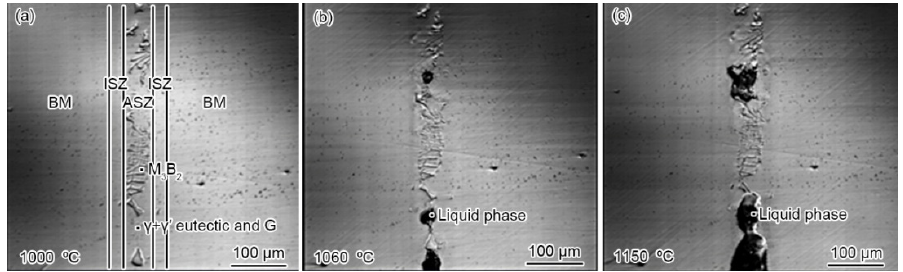
Figure 10. The microstructural evolution of the as-prepared joint during the heating process: mi- crostructure at ( a ) 1000 °C ( b ) 1060 °C ( c ) 1150 °C.